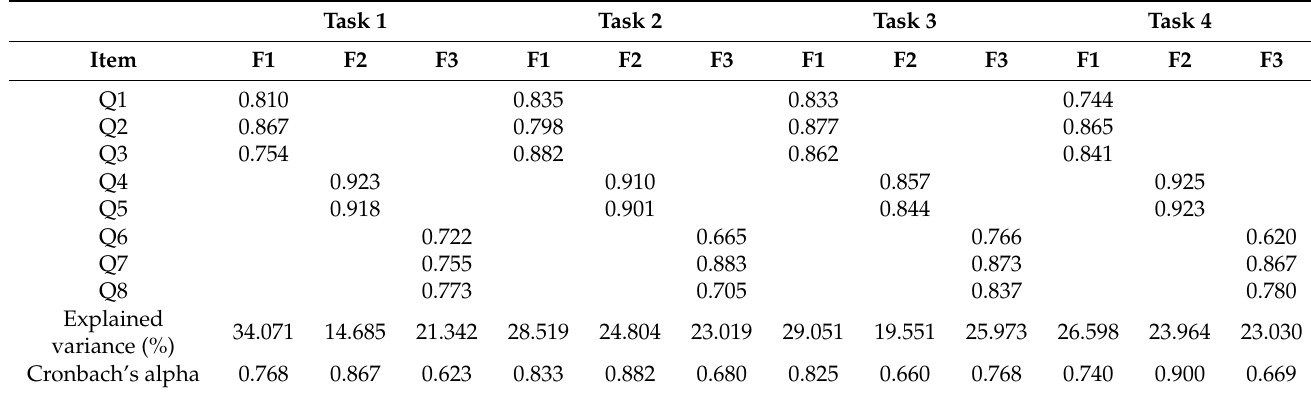
Table 3. Exploratory factor analysis for each task (Q1–Q8).